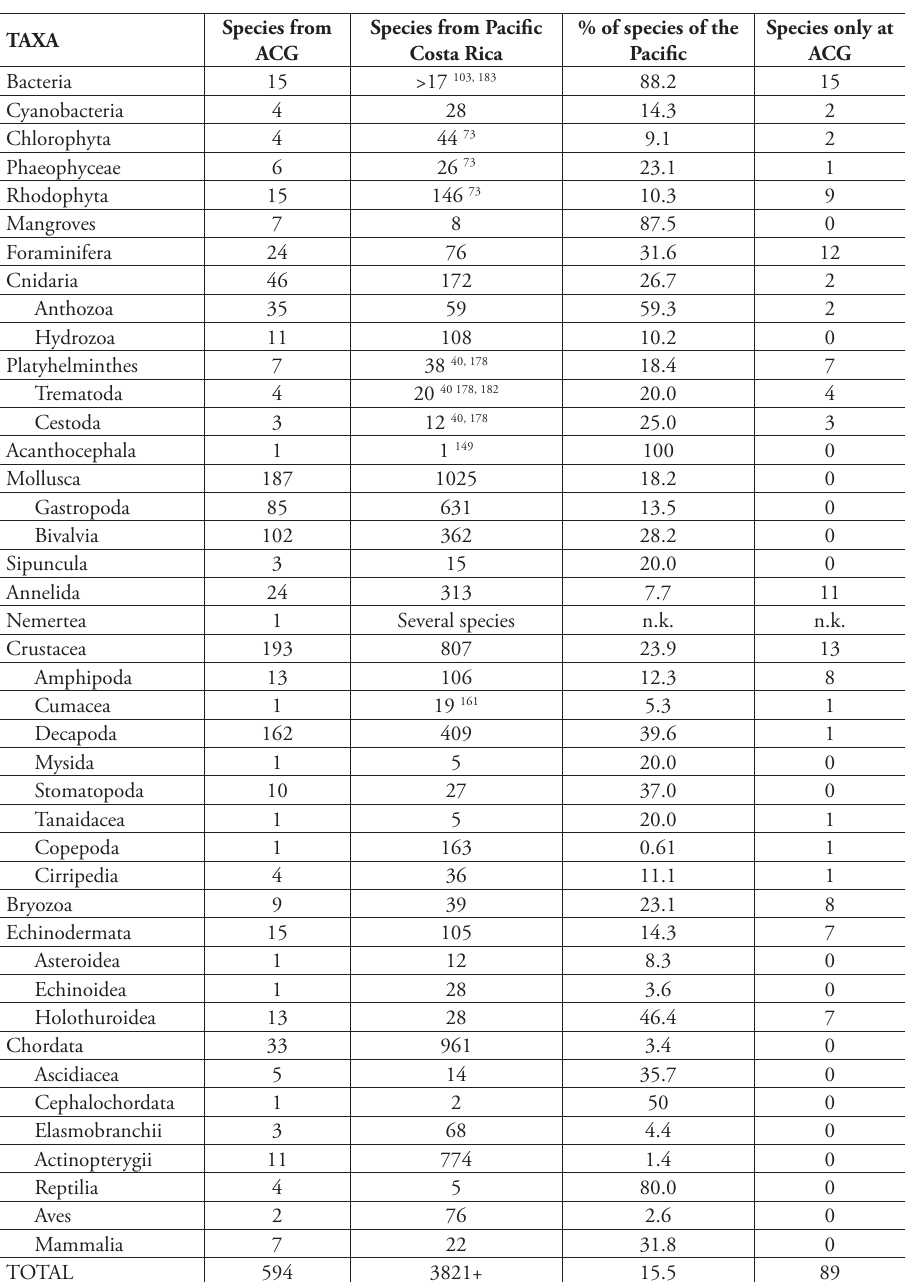
Table 3. Number of marine species reported from Área de Conservación Guanacaste (complete list of species in the Appendix), Pacific coast of Costa Rica (see Cortés 2012, plus references indicated as su- perindex) (species reported only for Isla del Coco were excluded); percentage of the species of the Pacific reported form ACG, and species only found in ACG. n.k. = not